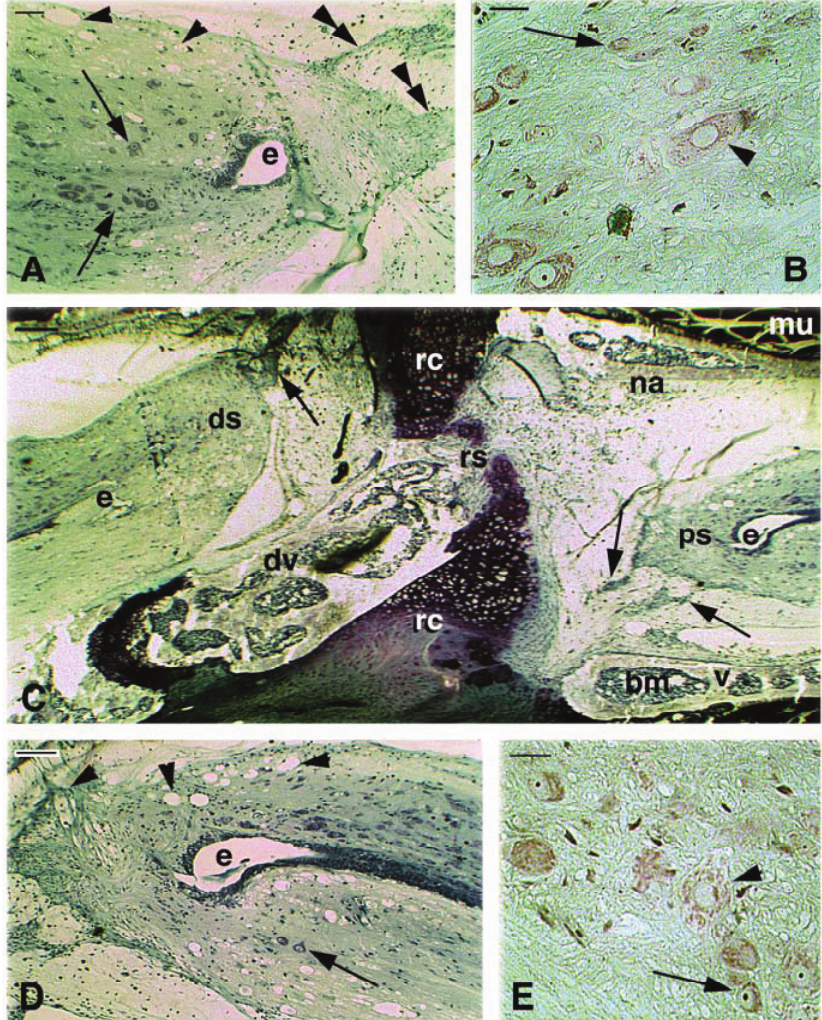
Figure 4. Detail of longitudinal sections from an animal with little recovery at 36 days post-lesion. A , distal stump showing the enlargement of the ependymal canal and numerous apparently normal neurons (arrows). Arrowheads indicate vacuolated areas resulting from neuropile/axonal degeneration. Double arrowheads point to the beginning of the bridge tissue. Scale bar, 30 (cid:2) m. B , cytological detail of interneurons (arrow) and larger nerve cell bodies (arrowhead) containing granulated Nissl material, located in the distal stump of the spinal cord. Scale bar, 10 (cid:2) m. C , gap region between proximal and distal spinal cord stumps showing that a dislocated vertebra (through the surgical procedure) has largely obliterated the neural canal together the regenerated cartilage. The arrow indicates the neural arch bone. The arrowhead indicates the bone of the vertebral body. Scale bar, 0.1 mm. D , enlargement of the ependymal ampulla formed in the proximal spinal cord stump. Note the numerous vacuolated degenerating axons (arrowheads). Scale bar, 20 (cid:2) m. E , detail of the proximal stump showing large ventral neurons (arrowhead) and sparse smaller neurons (arrow) containing coarse Nissl bodies, a typical sign of neuron reactivity to axotomy. Scale bar, 10 (cid:2) m. Legends: bm, bone marrow; dv, displaced vertebra; ds, distal stump of the spinal cord; e, ependyma; mu, muscles; na, neural arch; ps, proximal stump of the spinal cord; rc, regenerated